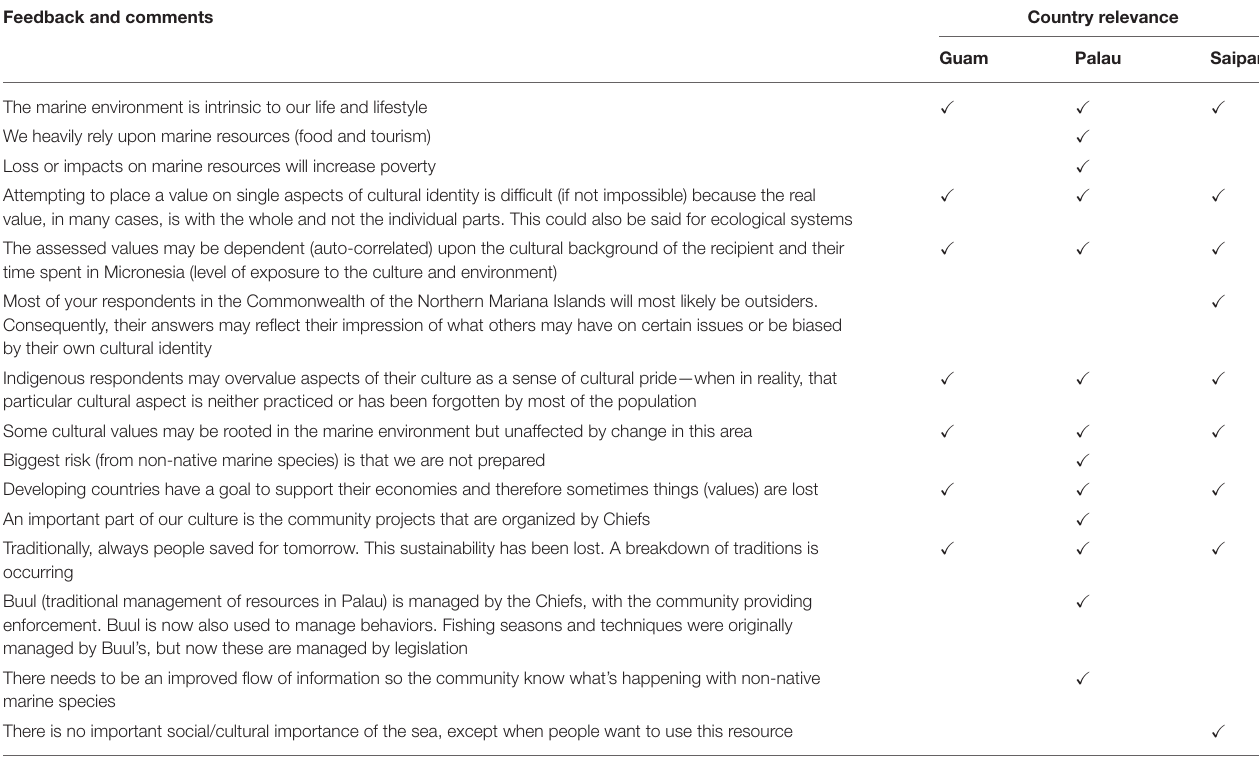
TABLE 1 | Respondent’s feedback and